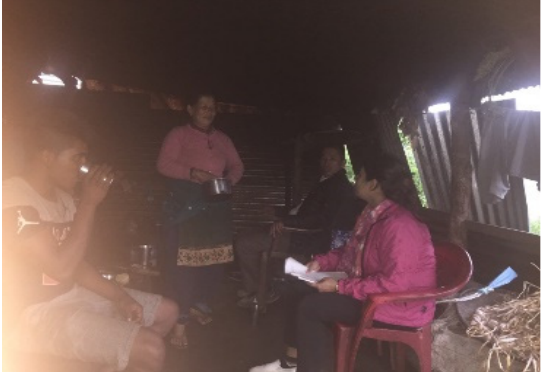
Figure 3. The figure shows the condition of temporary housing of the respondent after the 2015 Figure 3. Thefigureshowstheconditionoftemporaryhousingoftherespondentafterthe2015earthquake. earthquake. Under the Nepalese Government, the National Reconstruction Authority launched a program to support earthquake-affected families by providing cash to them to rebuild their houses. The fund allocated to each earthquake-affected household was NPR 300,000 (ap- proximately USD 2500). The Government of Nepal’s Department of Forestry had allocated 50 cu ft of wood for a completely damaged house, and 20 cu ft for a partially damaged house, to be provided for free for the reconstruction process. Similarly, for public buildings, the allocated wood was 100 cu ft for completely damaged buildings, and 40 cu ft for partially damaged buildings. Although the actual amount of wood required was more varied among the households, the government came to this decision based on the concept that more than 50% of the wood from damaged buildings could be reused, thus reducing the pressure on the forest. Different local and international organizations supported the earthquake-affected families in constructing earthquake-resistant houses. School